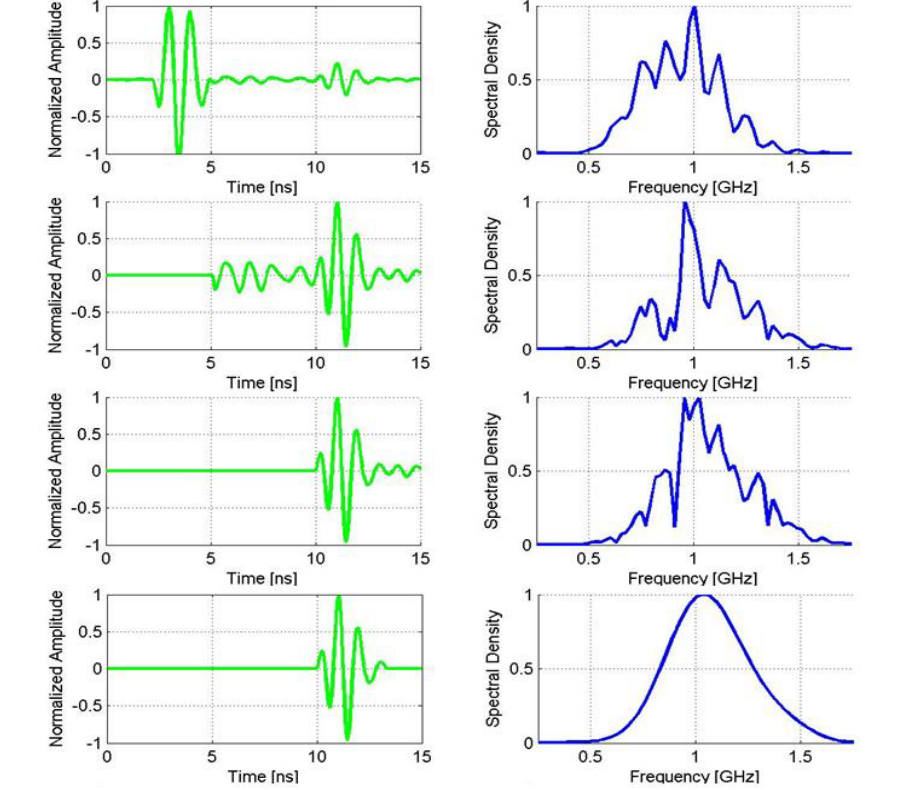
Figure 13. This sequence (from top to bottom) represents the process by which a reflected wavelet is obtained from the entire recorded